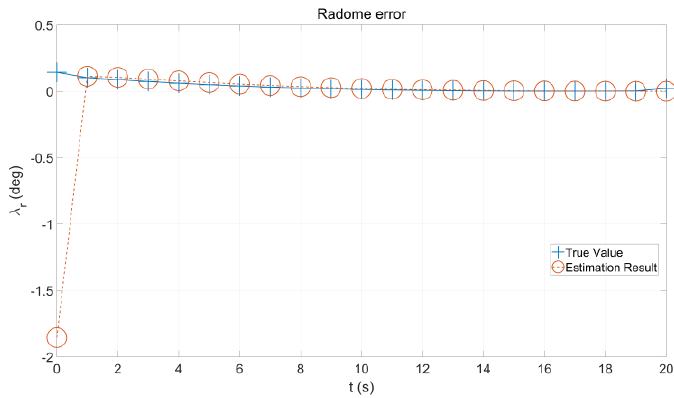
Figure 11. Trajectory of the look angle and corresponding estimates.